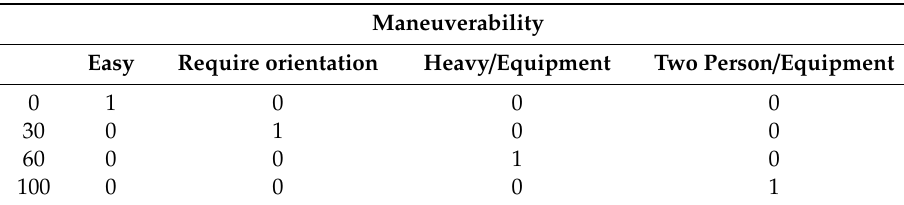
Table 10. Rule base for maneuverability.